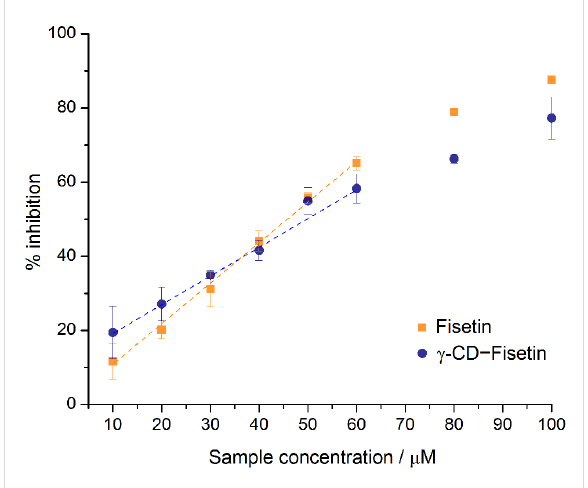
Figure 4: Antioxidant activity of the inclusion compound γ -CD·fisetin, compared with pure fisetin, as determined by the DPPH ˙ scavenging assay. Measurements were conducted at the steady-state of inhibition, occurring at 20 min of